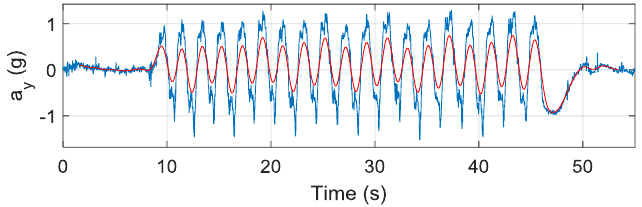
Figure 2. Raw acceleration (blue) with the overlapping sensor orientation (red).